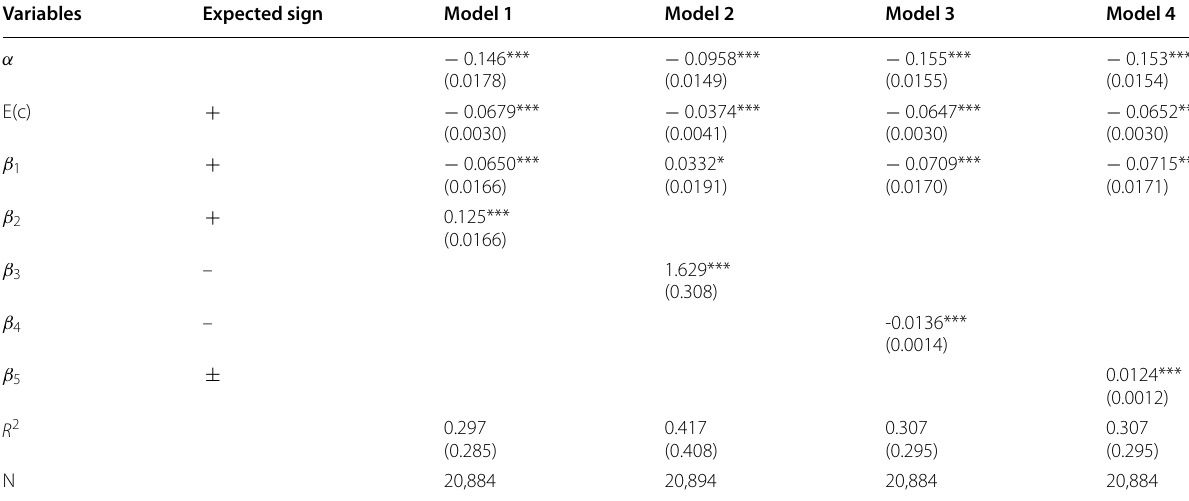
This table provides the LCAPM regression showing the impact of liquidity risk on stock returns. r i monthly stock returns, E(c) expected illiquidity costs, β 1 market stock beta, β 2 , β 3 , β 4 liquidity risk, β 5 aggregate liquidity risk. The number in parentheses with each coefficient represents the t -statistic estimated using the robust Newey- West method. The asterisks (*, **, ***) in the respective coefficients represent a significant level of 10%, 5%, and 1%, respectively. The R-squared ( R 2 ) is derived from the time-series average of all single cross-sectional regression and the adjusted R 2 is in the